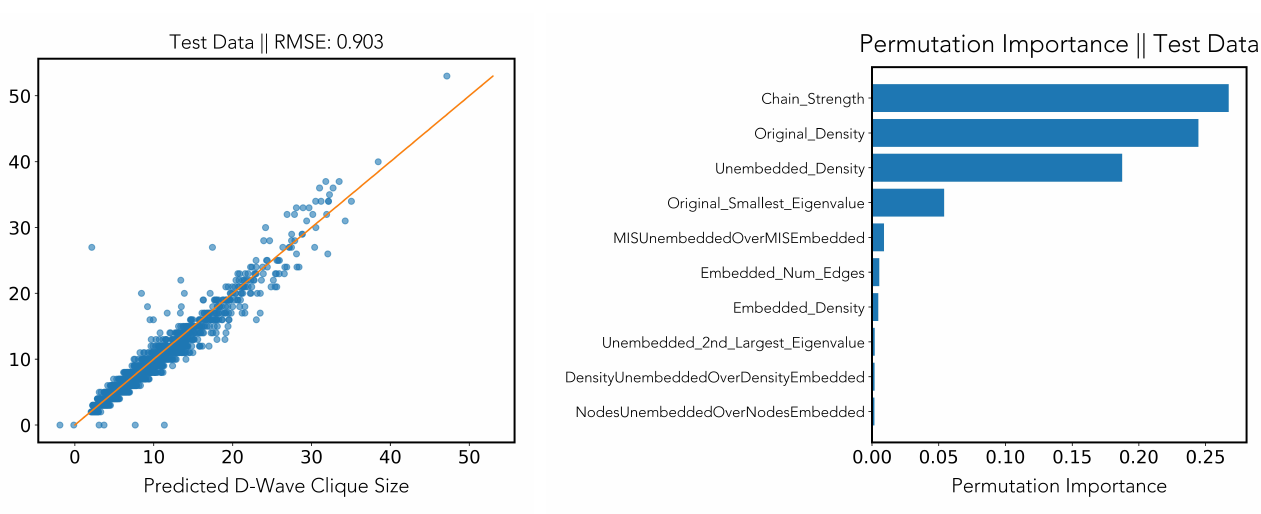
Figure 5. Regression via gradient boosting. ( Left ): predicted D-Wave clique size vs. true D-Wave clique size. ( Right ): permutation importance ranking. Setting of random annealing time and random UTC